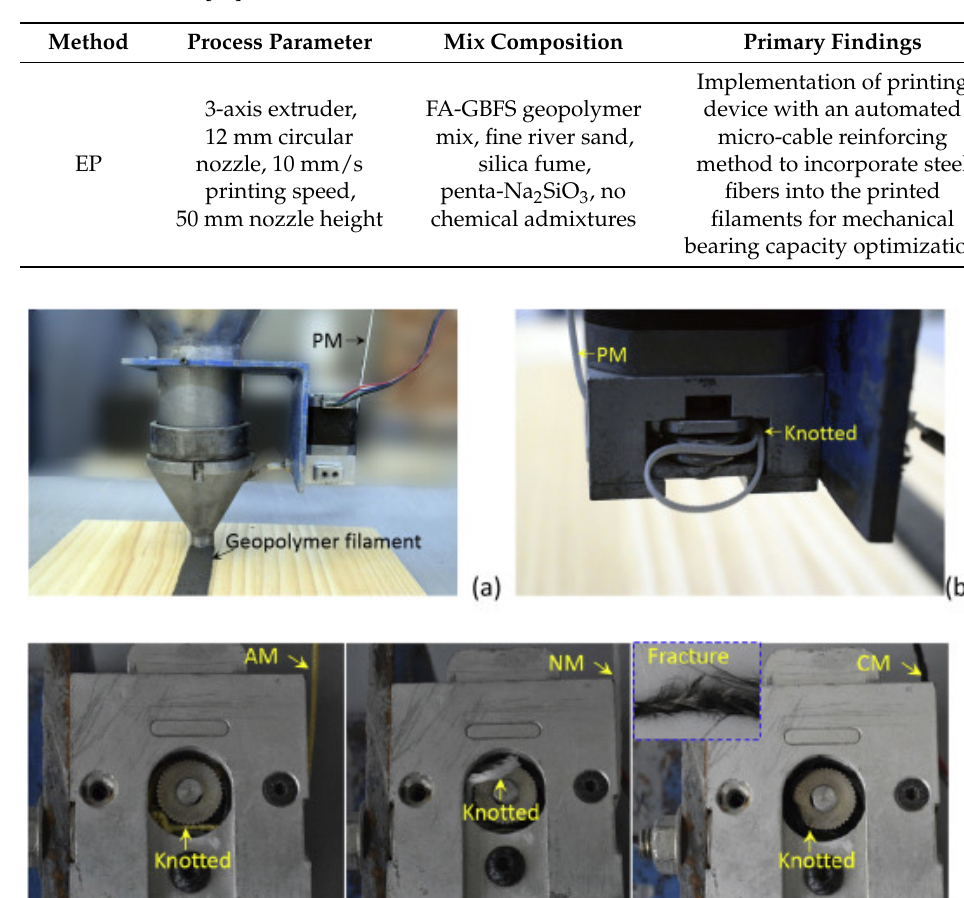
Table 6. Details of [89] research work.